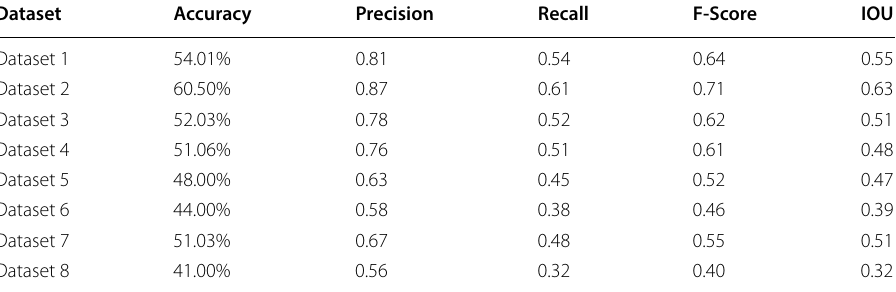
Table 2 Building extraction performance results (DSM)